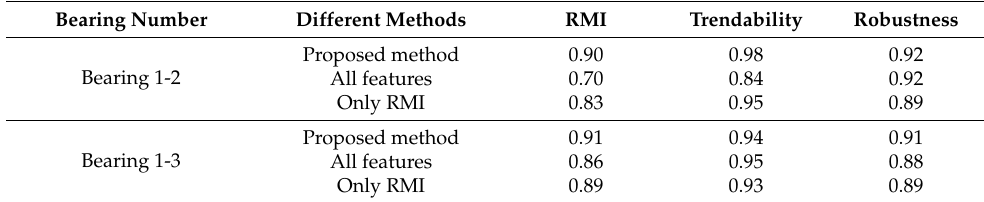
Table 8. Three different metrics of PIs by different